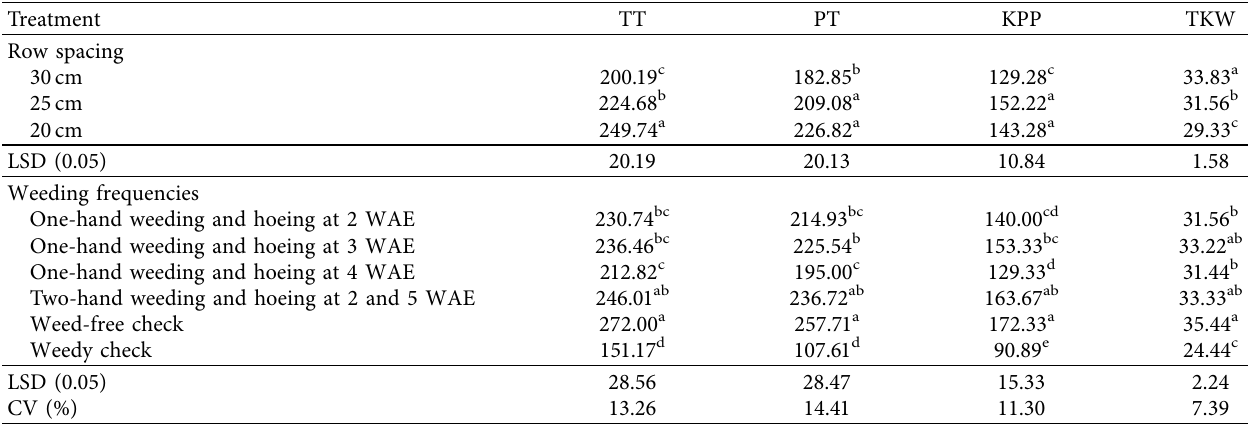
Table 5: Main effect of row spacing and weeding frequencies on yield components of rice at Kuja in 2020 main cropping season. Treatment TT